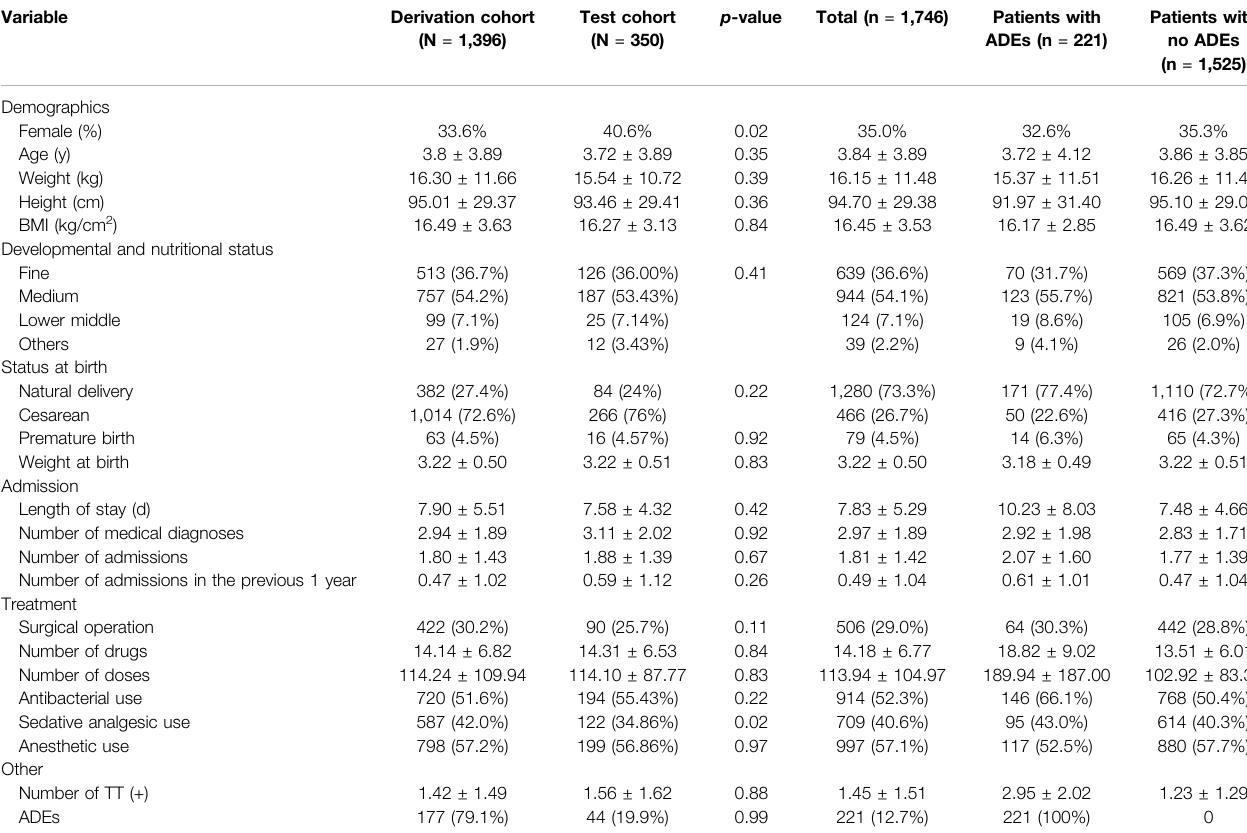
TABLE 1 | Characteristics of patients with and without ADEs.